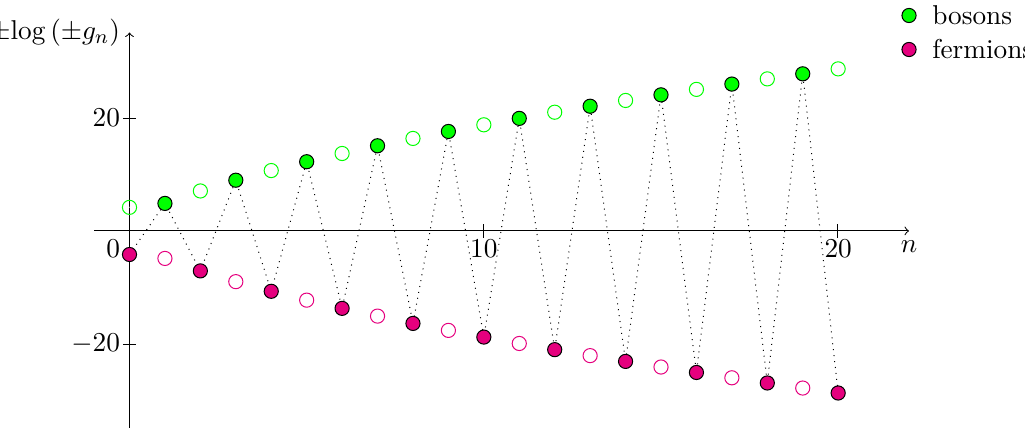
Figure 3 . The number of bosonic and fermionic physical degrees of freedom for the lightest energy levels for an anti-D p -brane on top of an O p -plane, defined as ( − 1) F n g point corresponds to states with mass M 2 to states that are invariant under the orientifold projection, whereas empty dots represent states that would be there if the anti-D p -brane was at a smooth point but that are projected out by the orientifold. One clearly sees the presence of misaligned